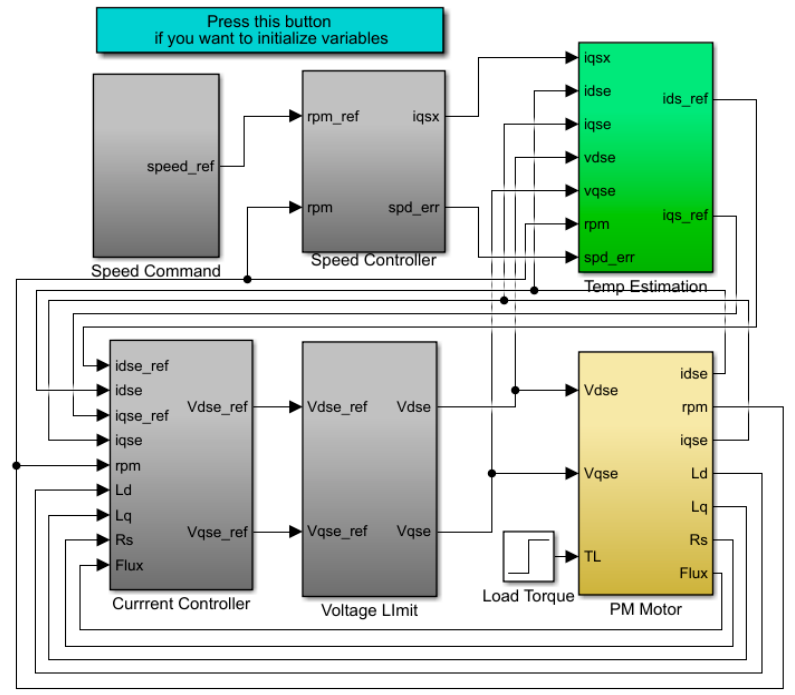
Figure 11. Simulation model for stator winding estimation.